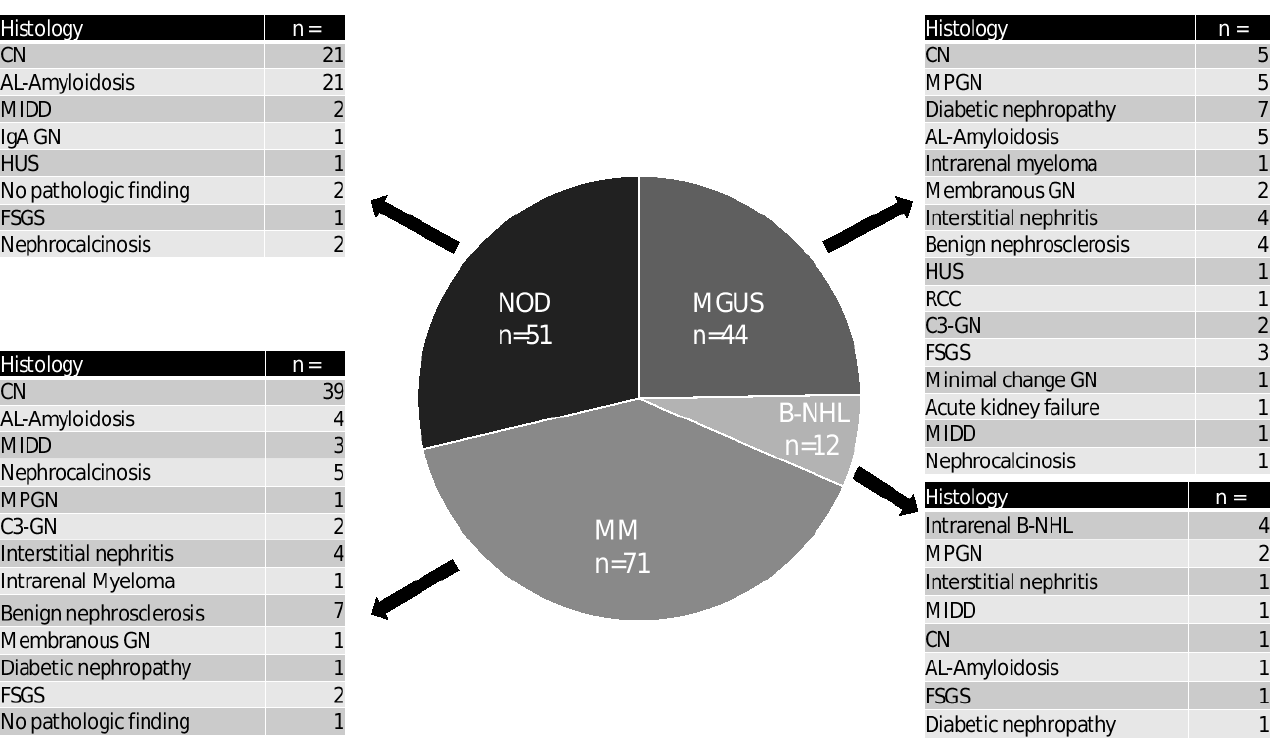
Figure 2. Examples of findings in kidney biopsies from patients with paraproteinemia. ( A ) Am- yloidosis with the typical homogenous depositions in the walls of arteries (upper part) and glomer- ular mesangium (lower part), showing positivity in the Congo-red stain (inlay). ( B ) Myeloma cast nephropathy with proteinaceous intratubular material accompanied by cell proliferation and light- chain restriction, as demonstrated by immunohistochemistry (inlay, lambda). ( C ) Light-chain dep- osition disease (LCDD) with nodular expansion of the mesangium resembling diabetic nodular glo- merulosclerosis Kimmelstiel–Wilson in conventional microscopy (upper half). Immunohistochem- istry revealing depositions of light chains, typically kappa (lower half). ( A – C ) PAS stains, original magnification 40×.